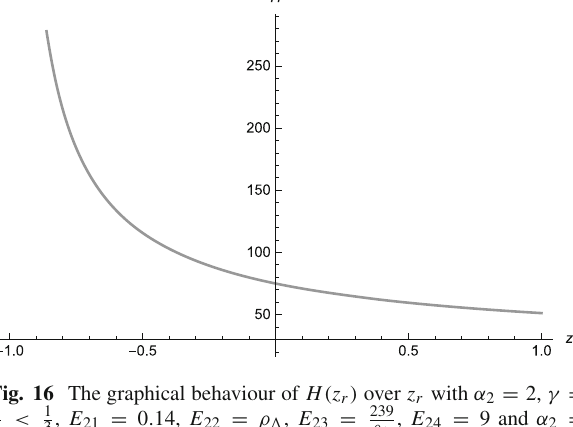
Fig. 16 The graphical behaviour of H ( z r ) over z r with α 2 = 2, γ = 1